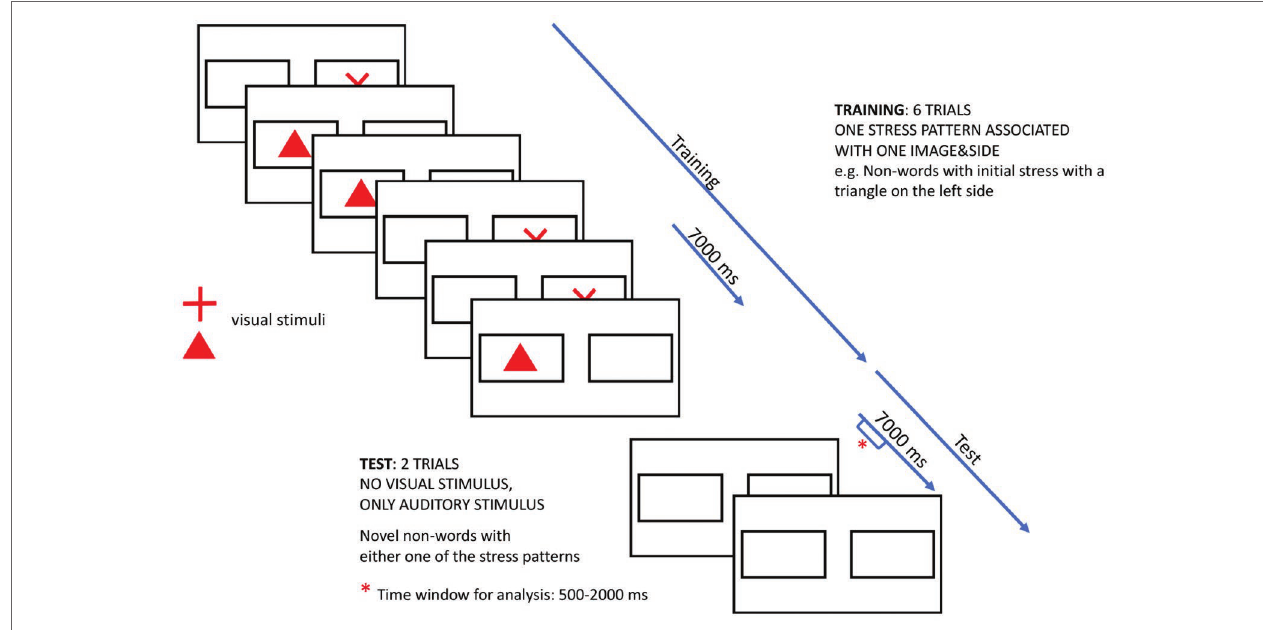
FIGURE 3 | Structure of an experimental